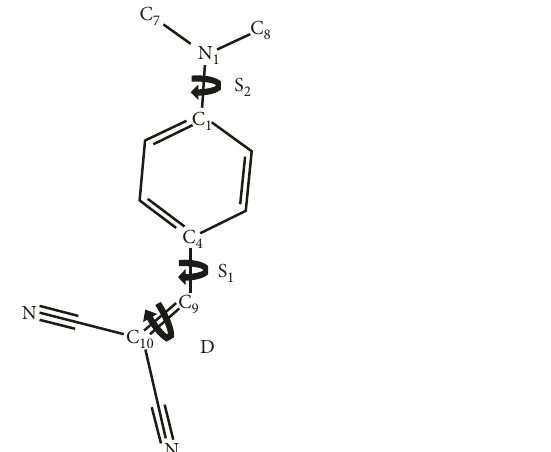
Figure 1: Optimized planar molecular structure of BMN showing the three main rotational pathways. The molecule is also planar in the first excited